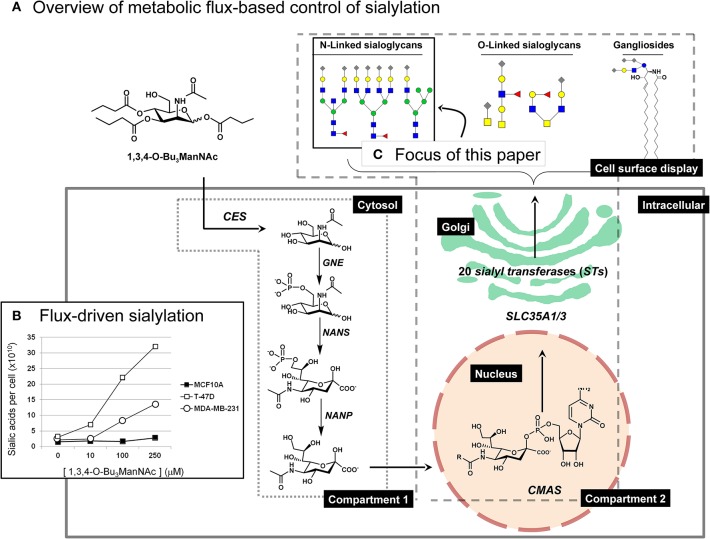
Overview of ManNAc analog-based control of flux through the sialic acid biosynthetic machinery. (A) The high-flux ManNAc analog 1,3,4-O-Bu3ManNAc efficiently diffuses across the plasma membrane after which non-specific esterases release the core ManNAc moiety by hydrolysis of the butyrate groups (Mathew et al., 2012). The kinase activity of GNE (or other kinases) and subsequent activities of NANS, and NANP in the cytosol converts ManNAc to sialic acid; these metabolites constitute “Compartment 1.” Once synthesized and dephosphorylated, sialic acid enters the nucleus where CMAS converts it to the corresponding nucleotide sugar (e.g., CMP-Neu5Ac); CMP-Neu5Ac is transported into the Golgi apparatus by SLC35A1 and SLC35A3 where a subset (depending on the cell line) of the 20 human STs create sialoglycoconjugates (primarily, N- and O-linked glycoproteins or gangliosides [i.e., sialic acid-modified glycosphingolipids]). (B) Representative results from a previous study (Saeui et al., 2018) are shown to illustrate the minimal (in the MCF-10A line) to large increase (in the T-47D line) that occurs in flux-driven sialylation in human breast cell lines (note that statistical significance for similar results is provided in Figure 2). (C) The focus of the current paper is to conduct a detailed “glycosite” analysis of cell surface glycoproteins obtained from 1,3,4-O-Bu3ManNAc treated cells. This figure is adapted from our previous publication (Saeui et al., 2018).